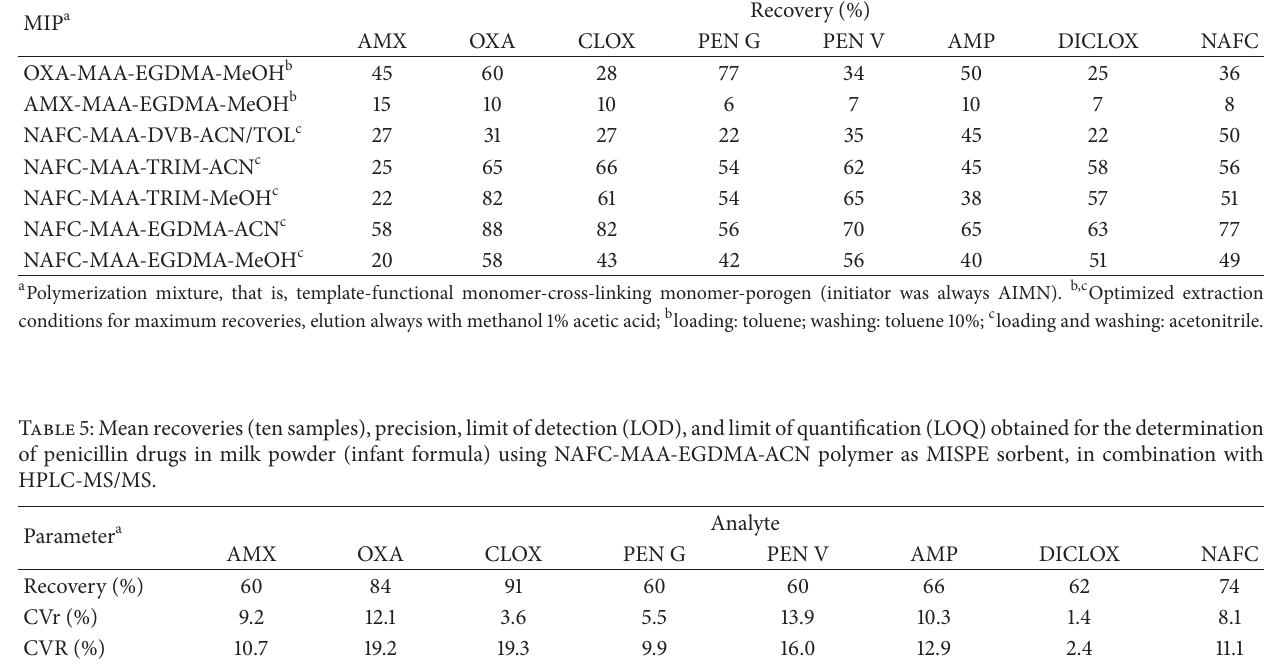
Table 4: Maximum recoveries achieved for the different penicillin-based MIP sorbents during MISPE optimization using standard solutions. MIP a